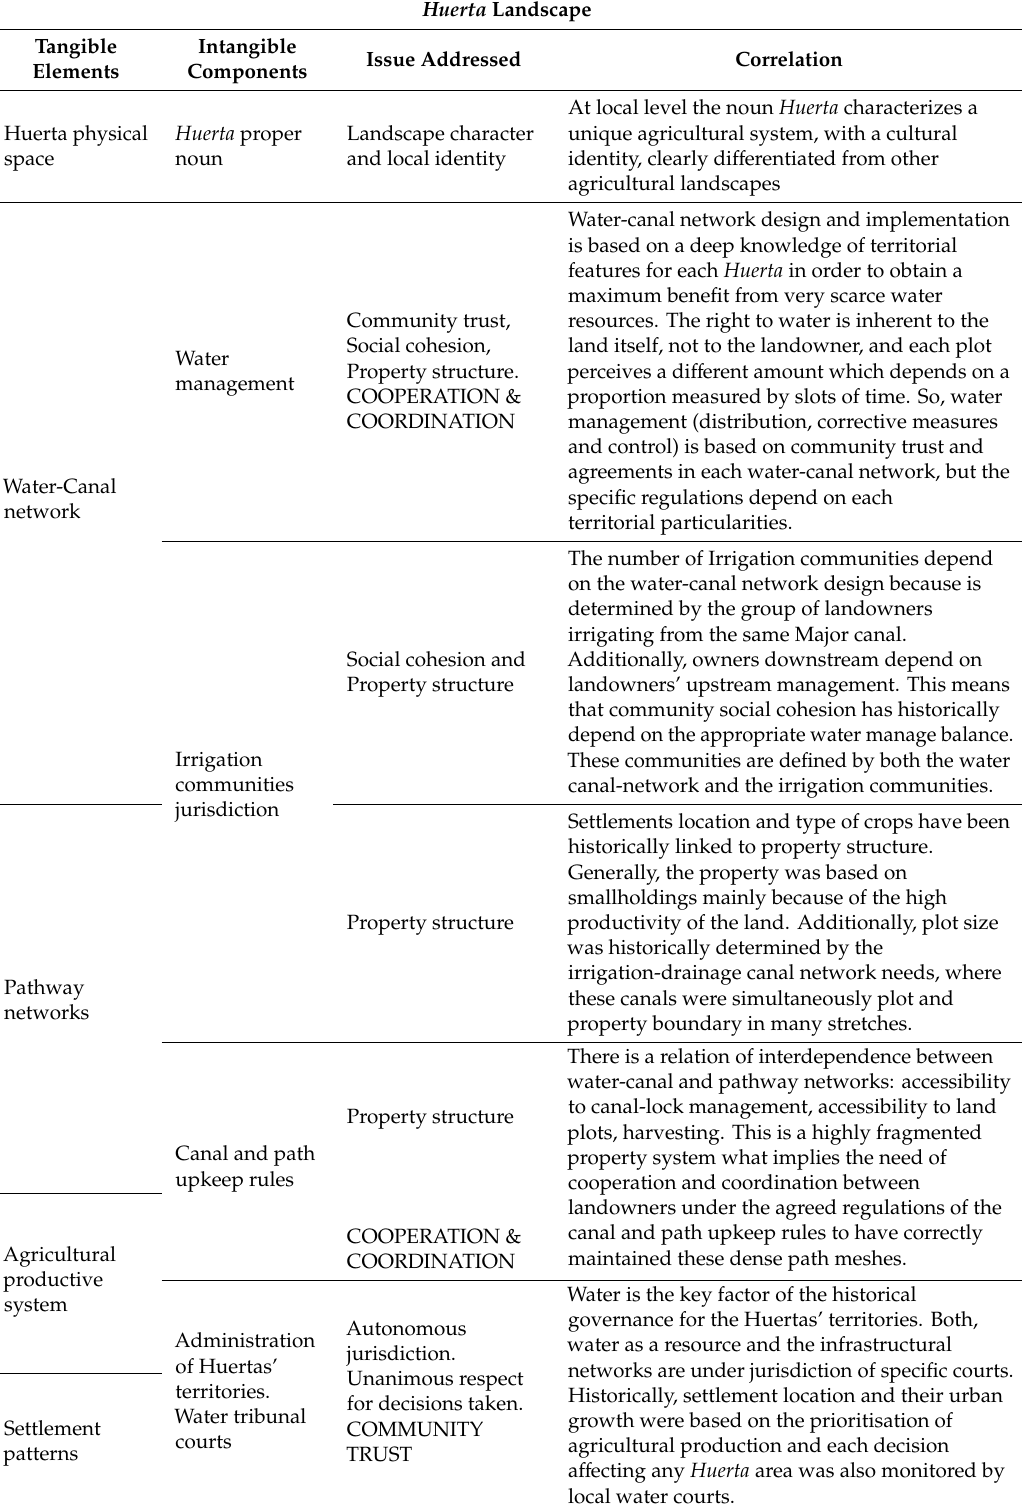
Table 2. Correlation between Tangible elements and Intangible components at Huerta landscape